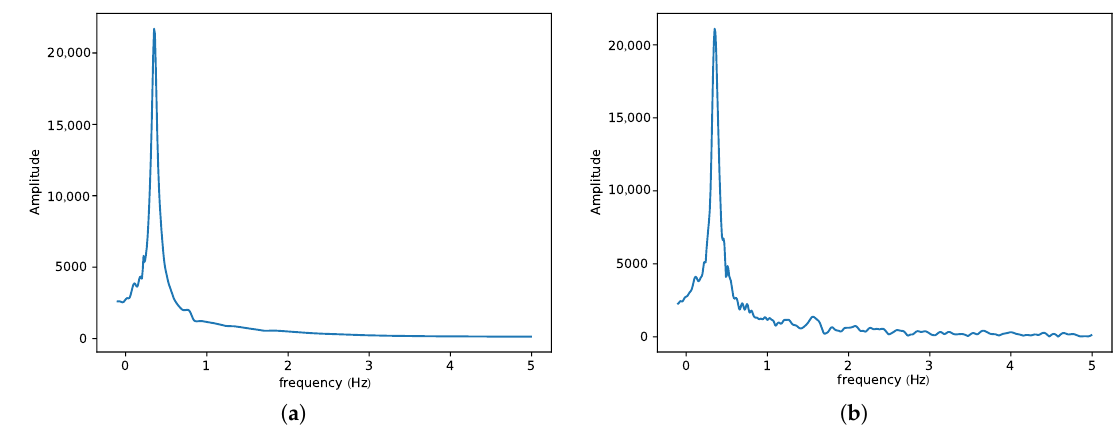
Figure 10. The effect of external excitation frequency on wind turbine rotational speed. ( a ) is for the case ω i = 0.02; and ( b ) is for the case ω i = 0.2. The other parameters used for these plots are